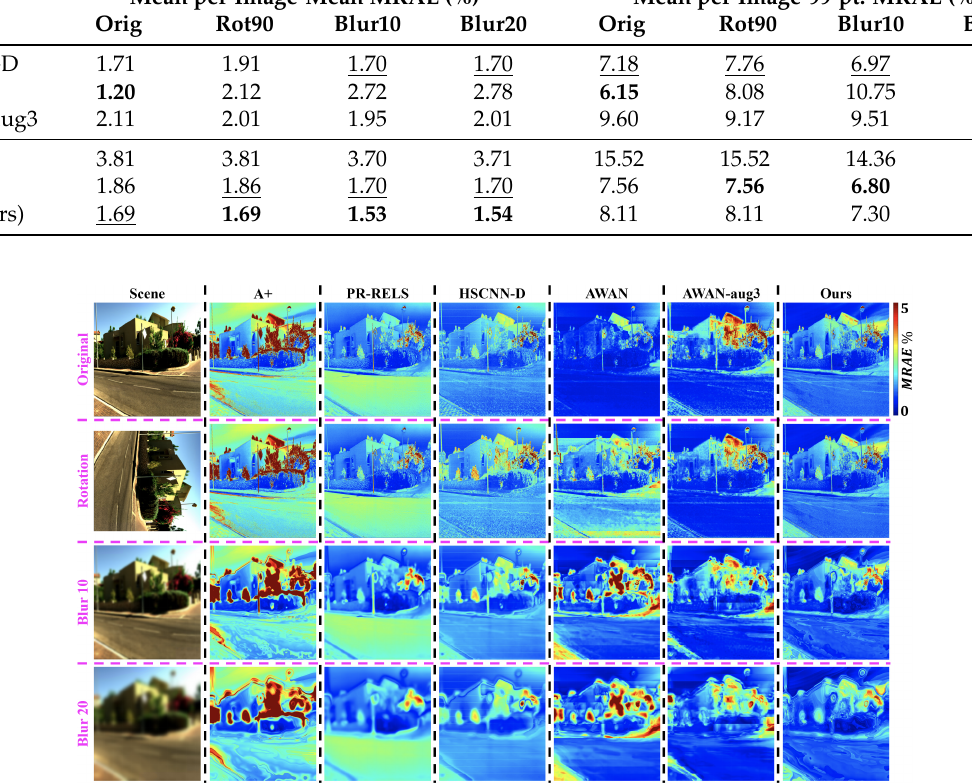
Figure 4. An example visualized hyperspectral image reconstruction performance by all compared methods. One scene from the ICVL database [44] shown in the left-most column is tested under the original ( top row ), rotation ( middle row ), and two Gaussian blur conditions ( bottom 2 rows ). The er- ror maps for the rotation condition are rotated back to an upright orientation to ease the comparison.